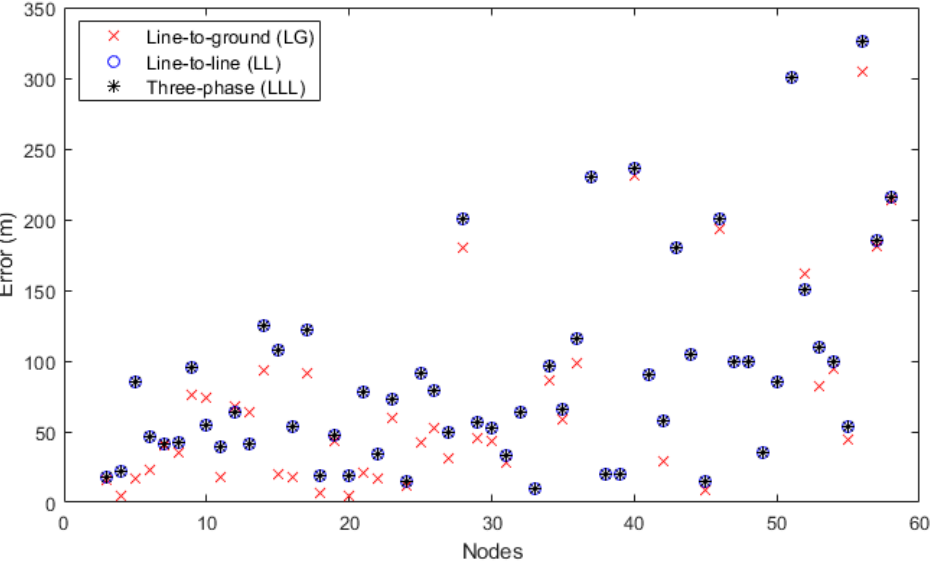
Table 4. Utilization factor in light and heavy load